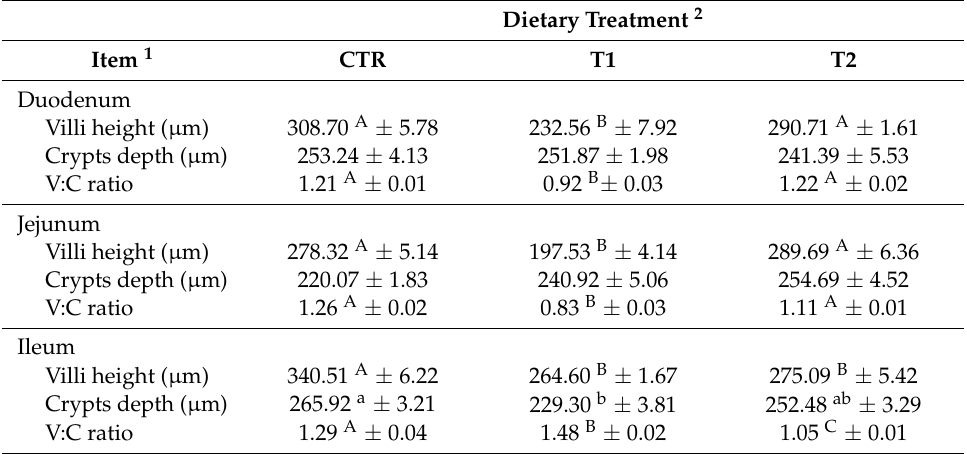
Table 1. Histometrical analyses of the small intestine in piglets exposed to oxidative stress. Dietary Treatment